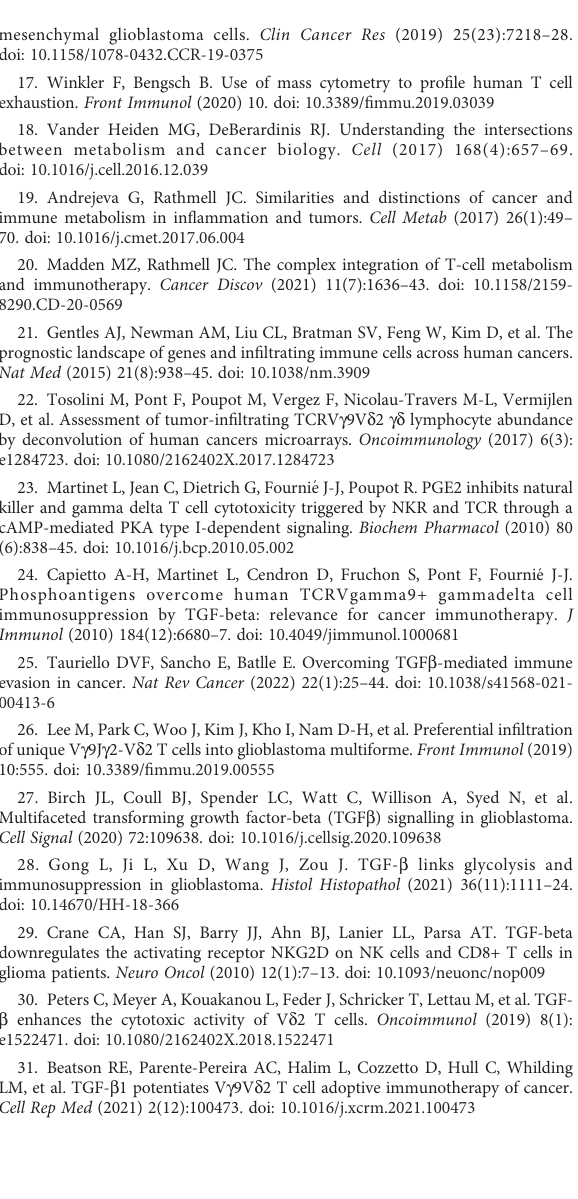
SUPPLEMENTARY FIGURE 1 Gating strategies selected for the analysis by fl ow cytometry of the impact of TGF- b on human V g 9V d 2 T cells. Left , selection of V d 2 + T cells (Vd2 subset, purity indicated=95.4%) within PBMC. Right up , CD107a expression on activated V d 2 + T cells; Right, low , NKG2D expression levels on TGF- b -treated ( purple histogram ) or untreated ( blue